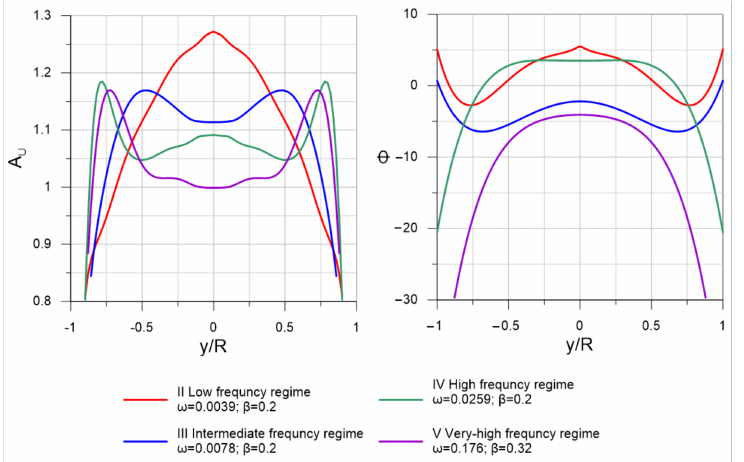
Figure 5. Amplitude A U of velocity modulation in pulsating flows and phase shift Φ of velocity modulation relative to the imposed flow